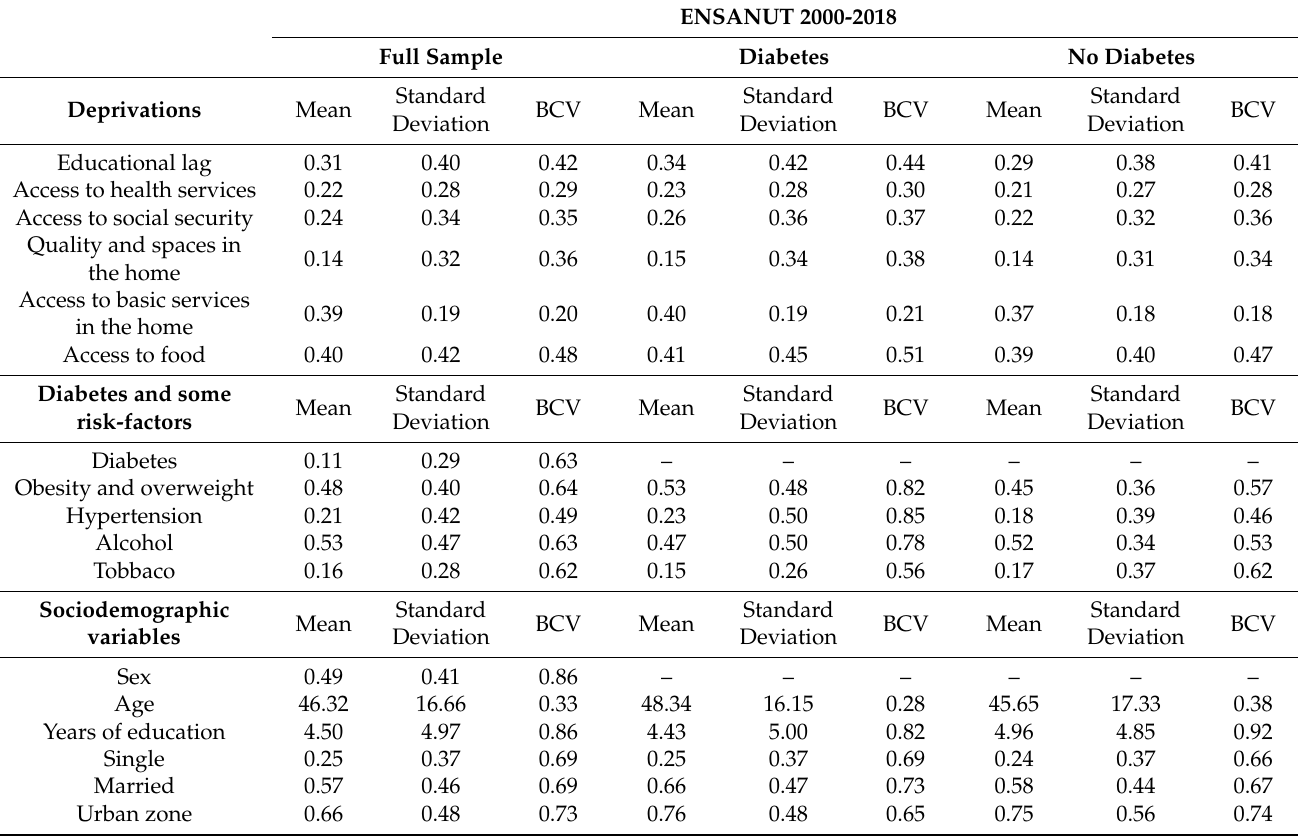
Table 2. Basic statistics of the sample